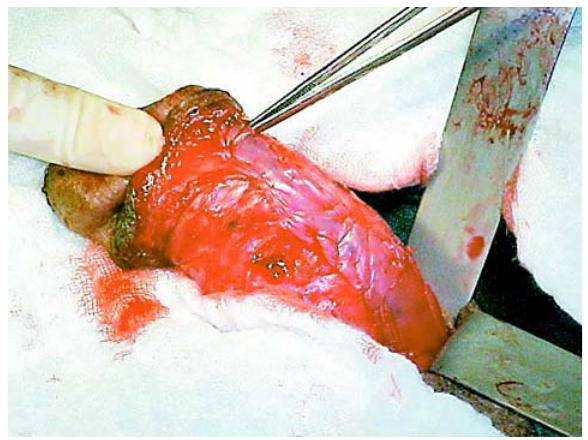
Figure 3 – Aspect of the prosthesis lined with the bovine